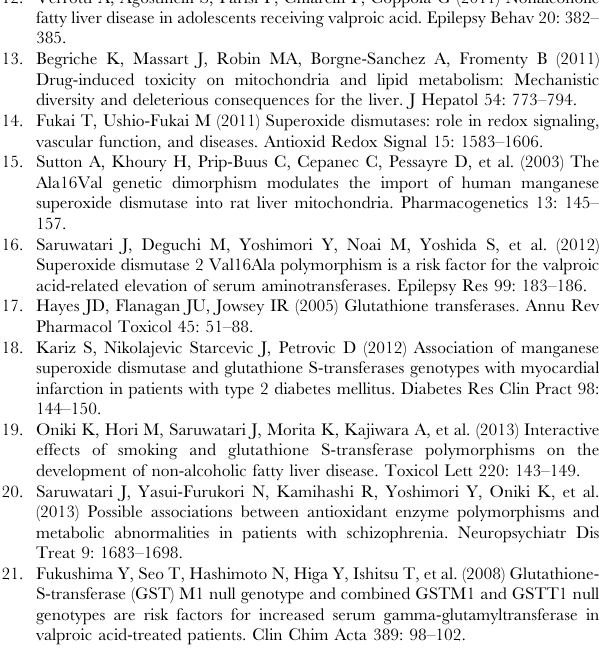
Table S2 The effects of the tested covariates on the objective function of the PK-PD parameters regarding the probability of a VPA-induced c -GT elevation.